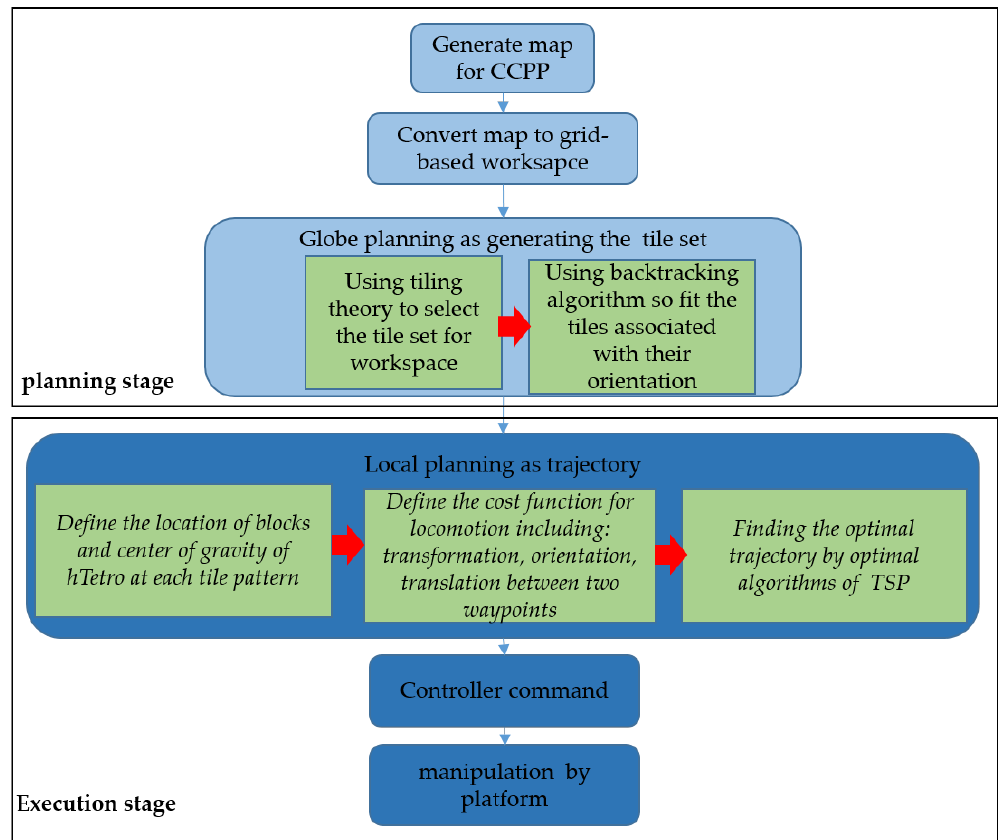
Figure 6. The proposed complete coverage path planning